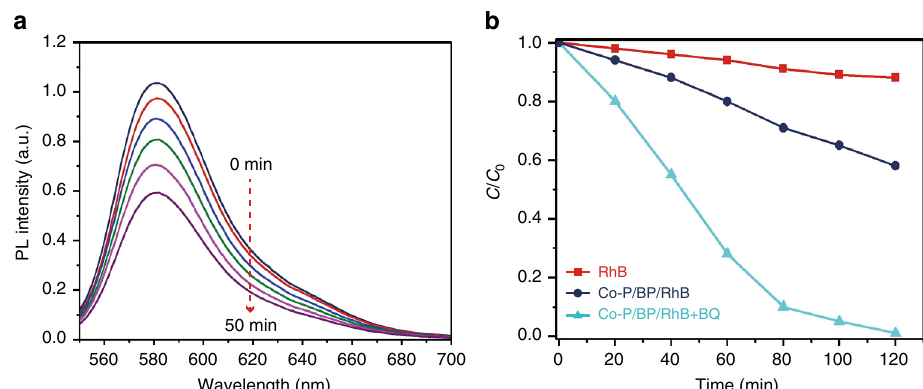
Fig. 7 Determination of oxydates of water by photogenerated holes in the system. a Time-dependent fl uorescence emission spectra of the SFT reacted with NO 2 − formed from the reaction between hydroxylamine hydrochloride and ·O 2 − in the Co-P/BP suspension system under Xe lamp irradiation ( λ ≥ 420 nm). b Photodegradation activity of RhB under different conditions. Red line: pristine RhB solution; navy line: Co-P/BP and RhB solution; and light blue line: 1 mM benzoquinone and Co-P/BP and RhB solution. The light source is a 300-W Xe lamp ( λ ≥ 420 nm) and irradiation power is 100 mW cm −